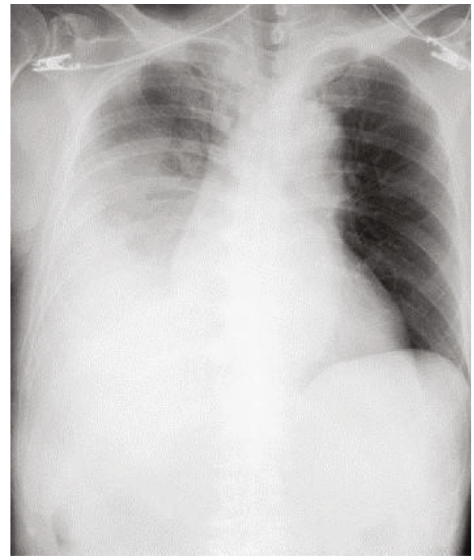
Figure 1: Chest X-ray fi ndings on arrival. Chest X-ray showed reduced permeability of the right lung fi